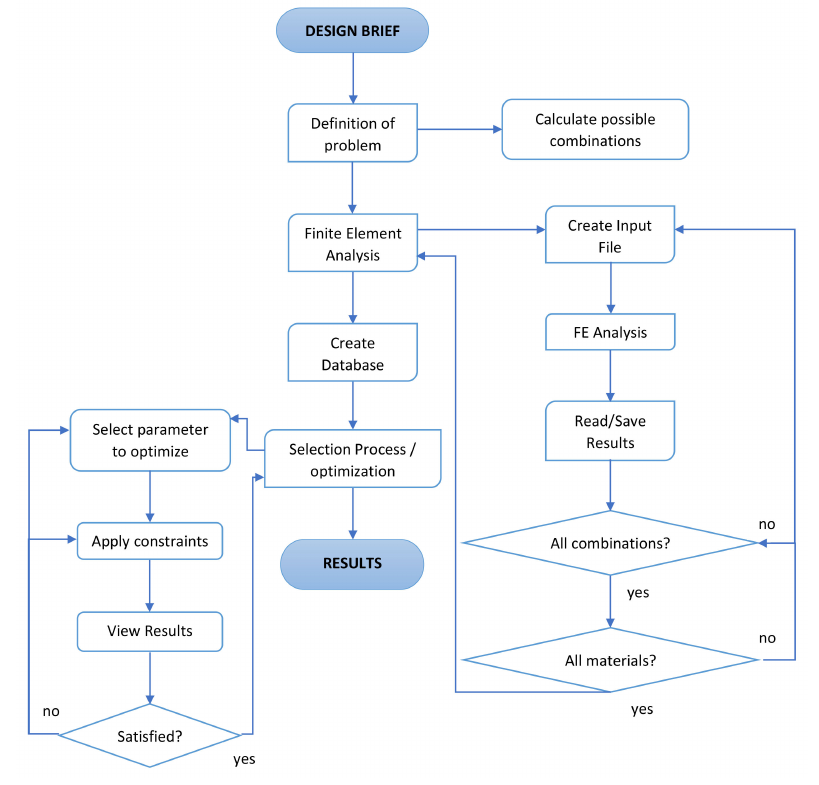
Figure 2. Design and FEA process flowchart adapted from